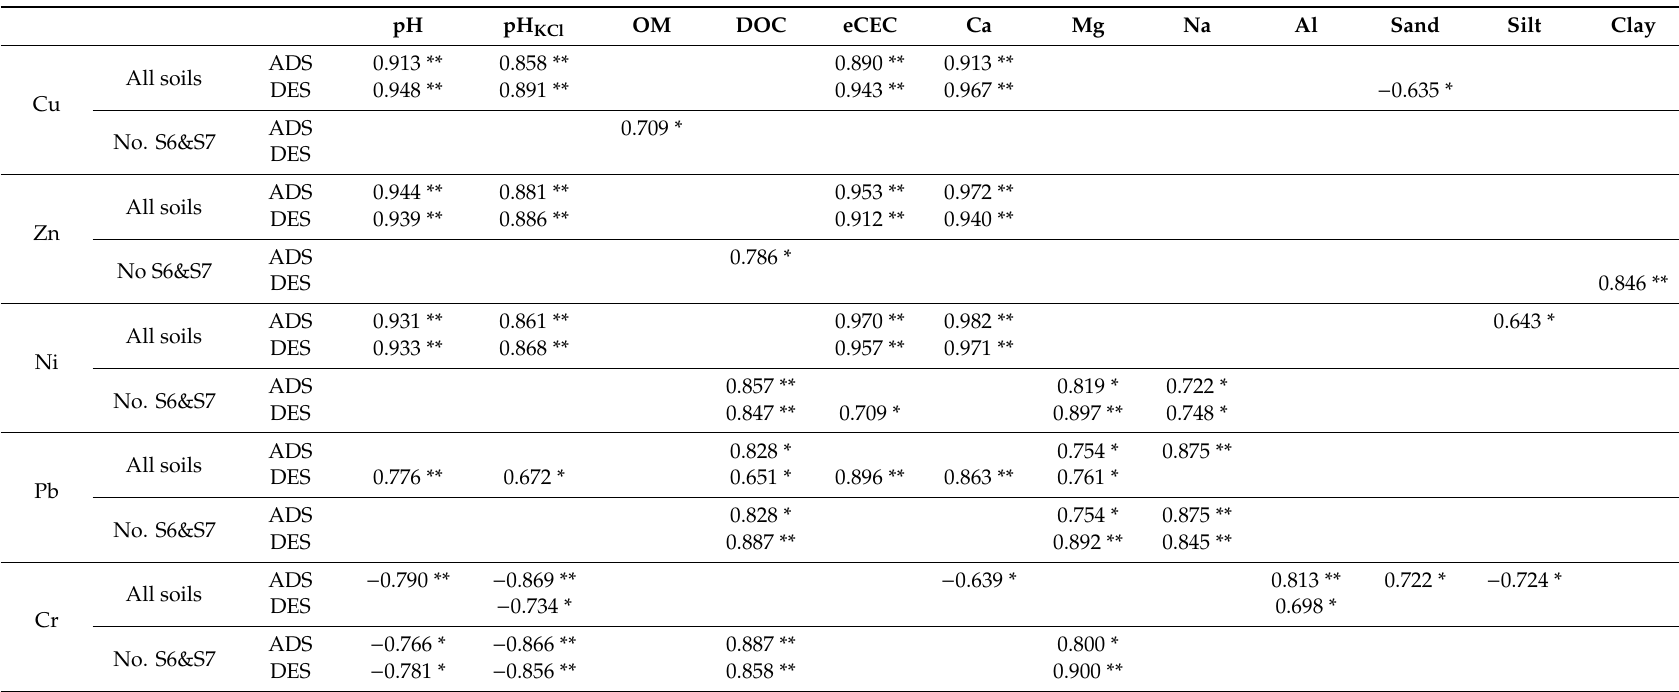
Table 3. Significative correlation coe ffi cients (at 0.01 * or 0.05 ** levels) from correlation analysis between soil properties and K F values (adsorption and desorption). N = 10, except for Pb ADS All soils ( N = 8) and S6 and S7 soils not